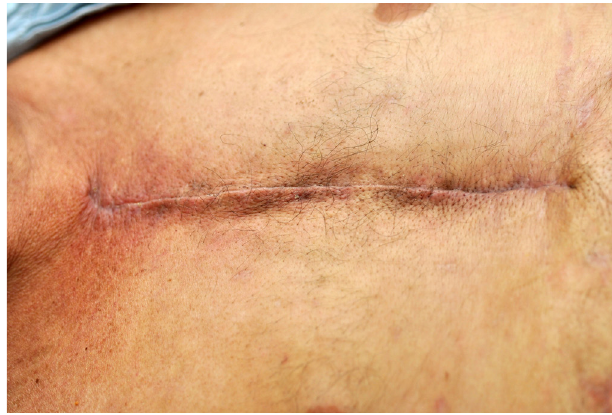
Fig. 1B - Male patient, 60 years of age with post-CABG dehiscence in the 35 th day after reconstruction. Classified as Type II, total length.